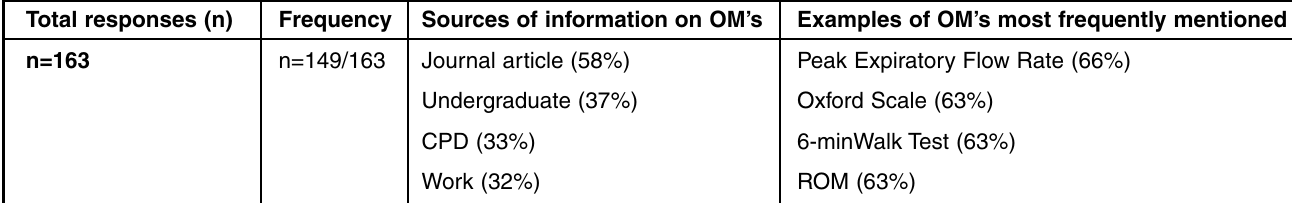
Table 1: Awareness of outcome measures amongst SA physiotherapists Total responses (n)